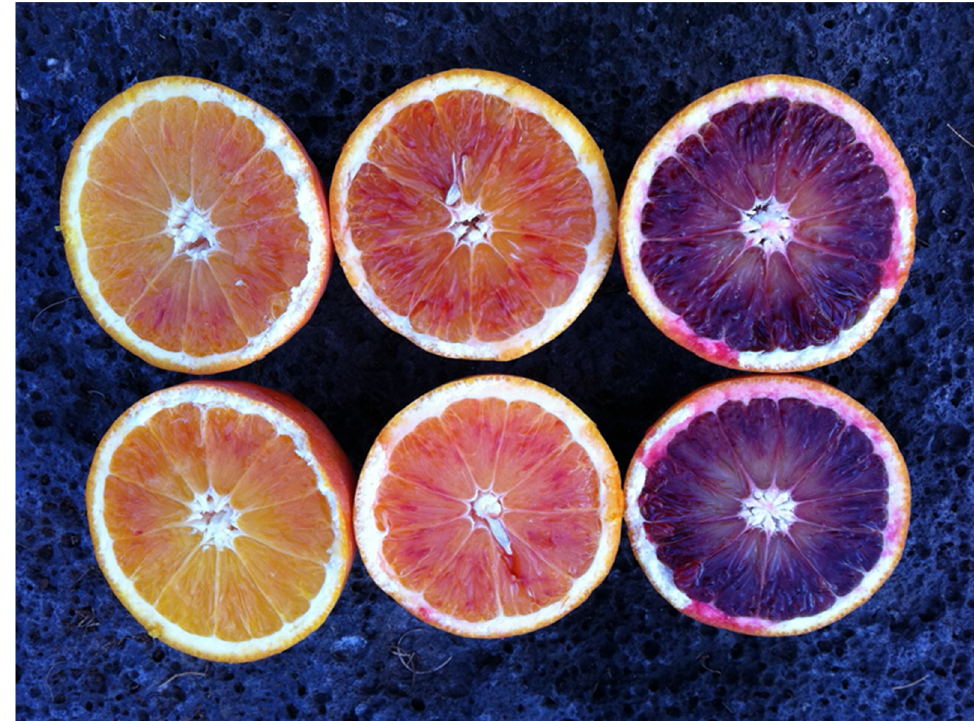
Figure 5. Fruit of “Tarocco Vigo” ( right ) compared to “Tarocco Comune” ( middle ) and “Tarocco dal Muso” ( left ) in mid-January (photo courtesy of Mr. Corrado Vigo).